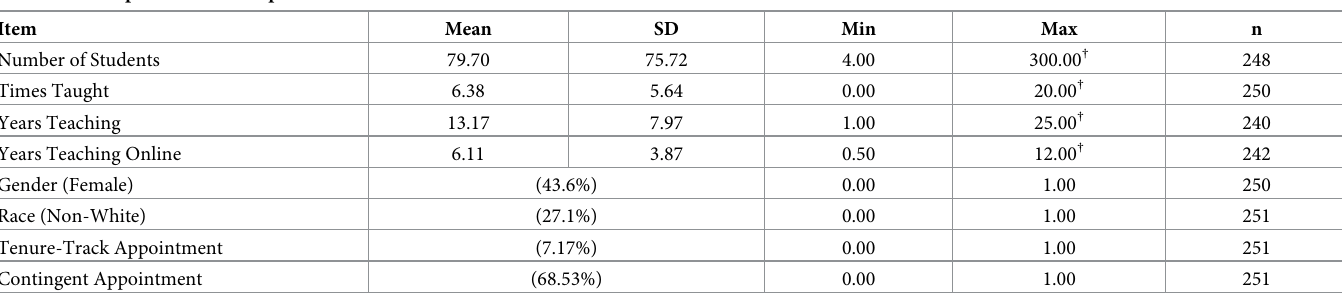
Table 1. Descriptive statistics of